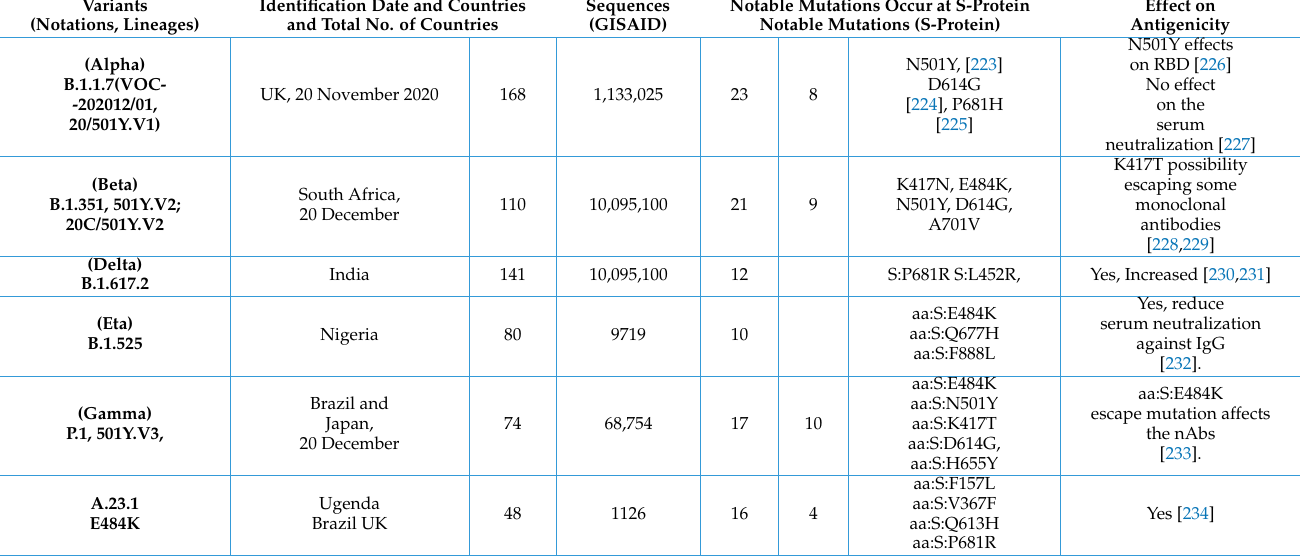
Table 3. Variants of SARS-CoV-2 and the significant mutations at the Spike